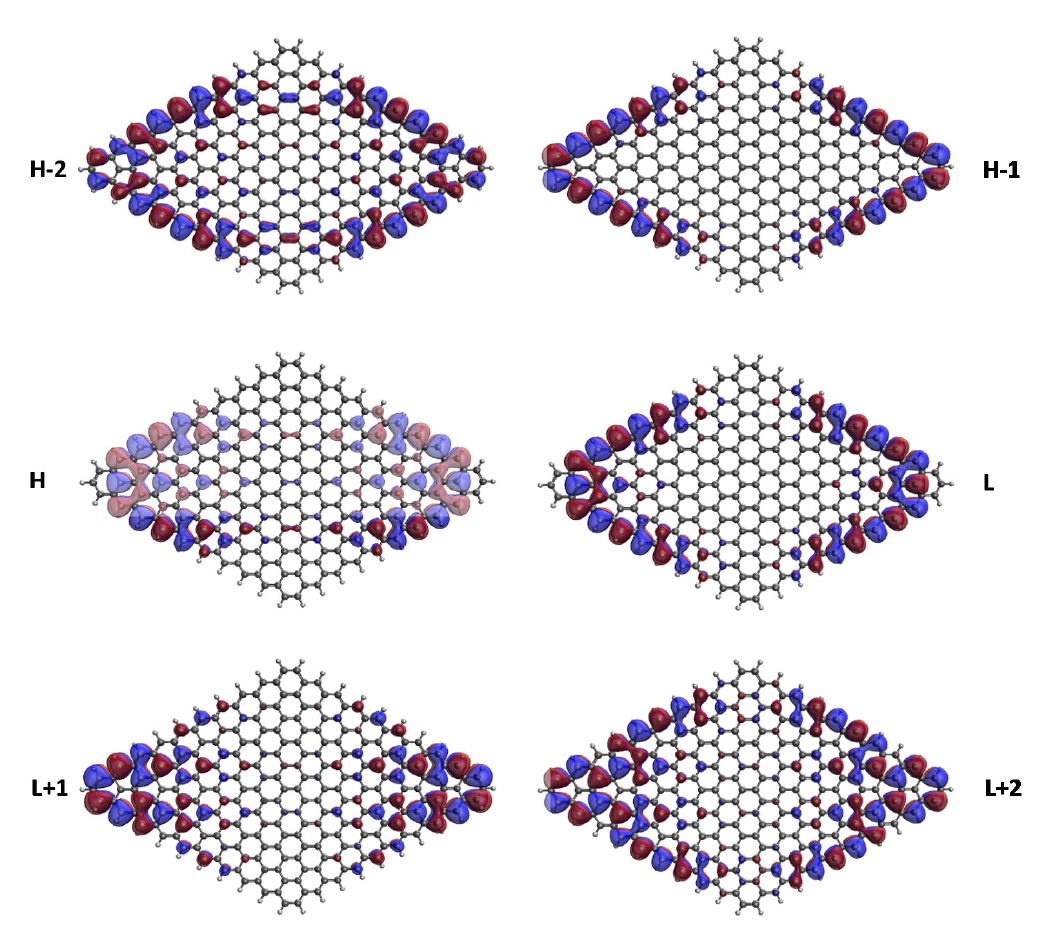
Figure 12. Real-space representation of H − 2 (1.133), H − 1 (1.040), H (1.038), L (1.011), L+1 (0.981), and L+2 (0.872) of ground-state 10-pyrene, calculated by spin-restricted TAO-LDA. Here the isovalue is 0.02 e/Å 3 . The occupation numbers of active orbitals are given in parentheses, and HOMO/LUMO is denoted as H/L for